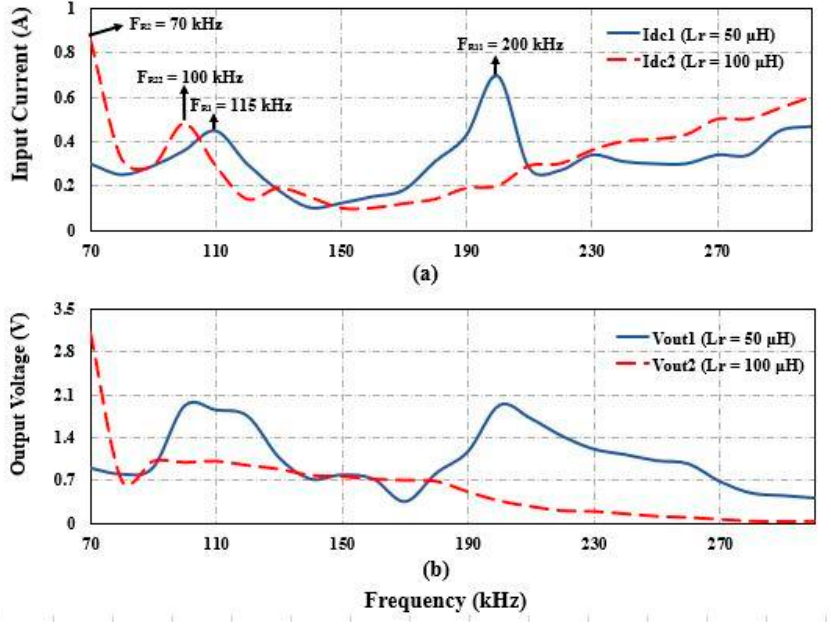
Figure 10. Hardware results of Class E 2 converter ( a ) Input current vs. Frequency, ( b ) Output Voltage vs. Frequency.